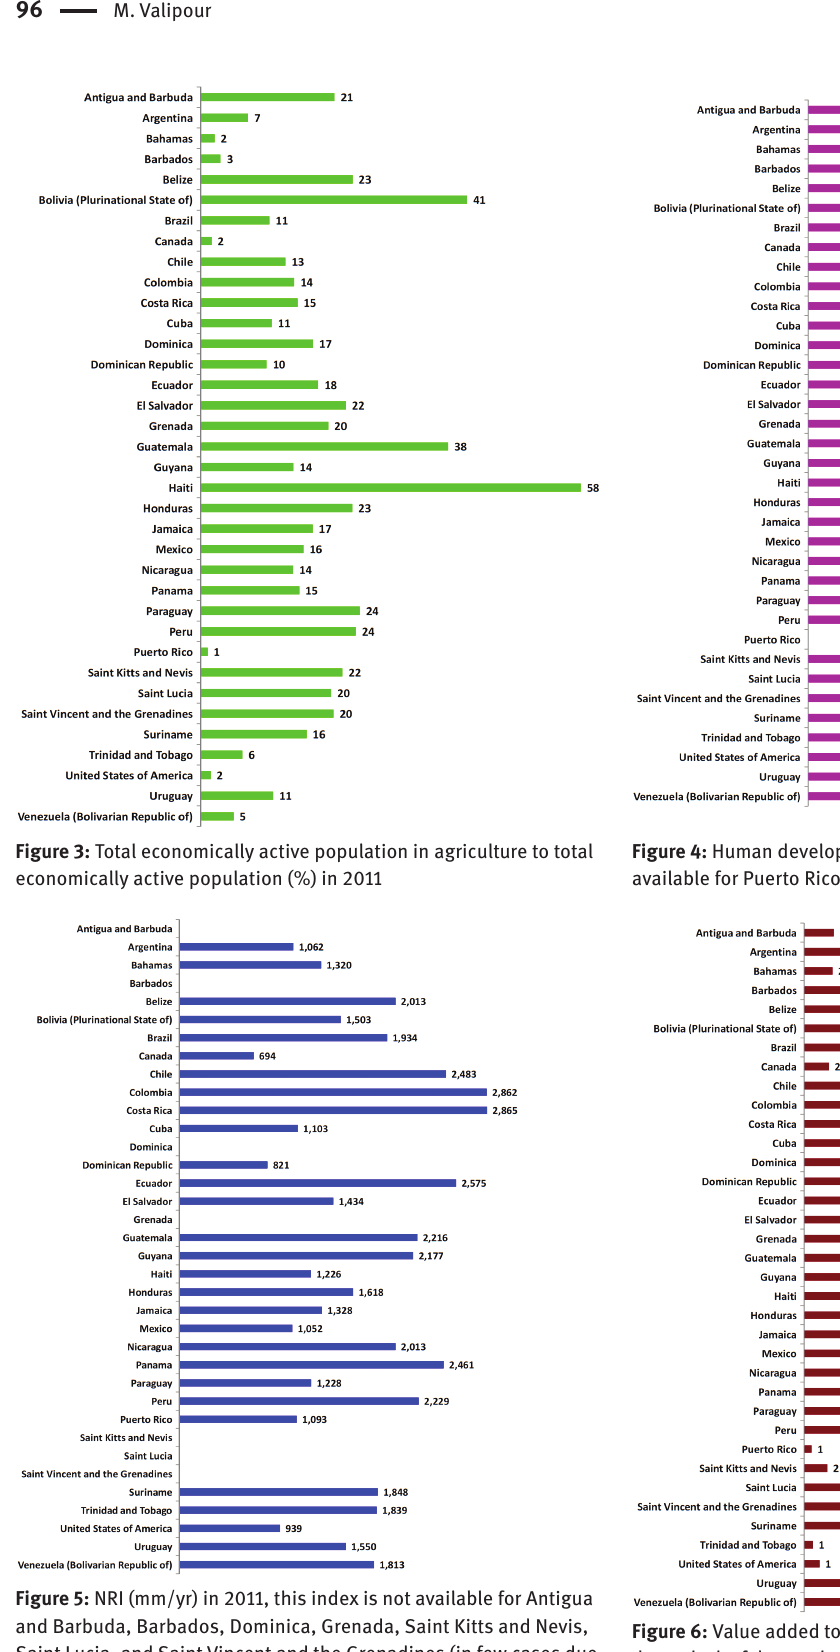
Figure 6: Value added to GDP by agriculture (%) in 2011 (in few cases due to lack of data, value of the index in the previous years has been